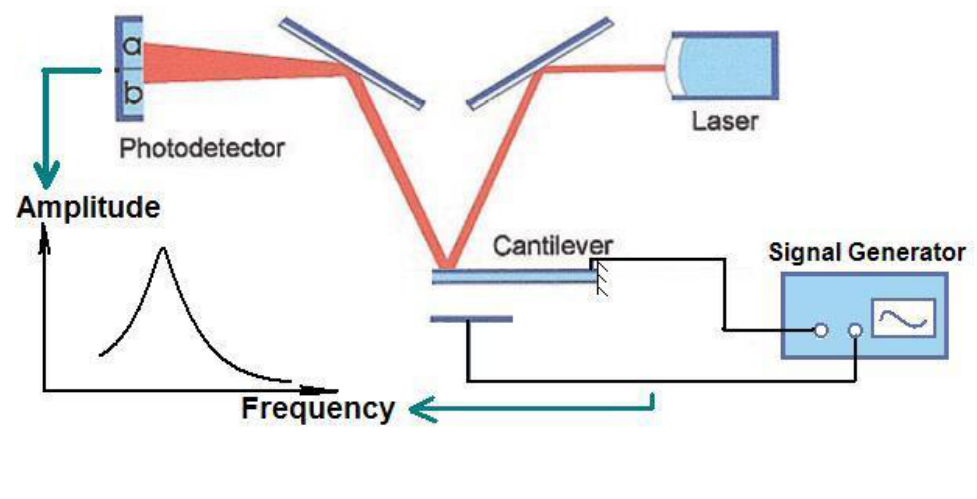
Figure 7. Schematic drawing of the experimental setup of the open-loop tests